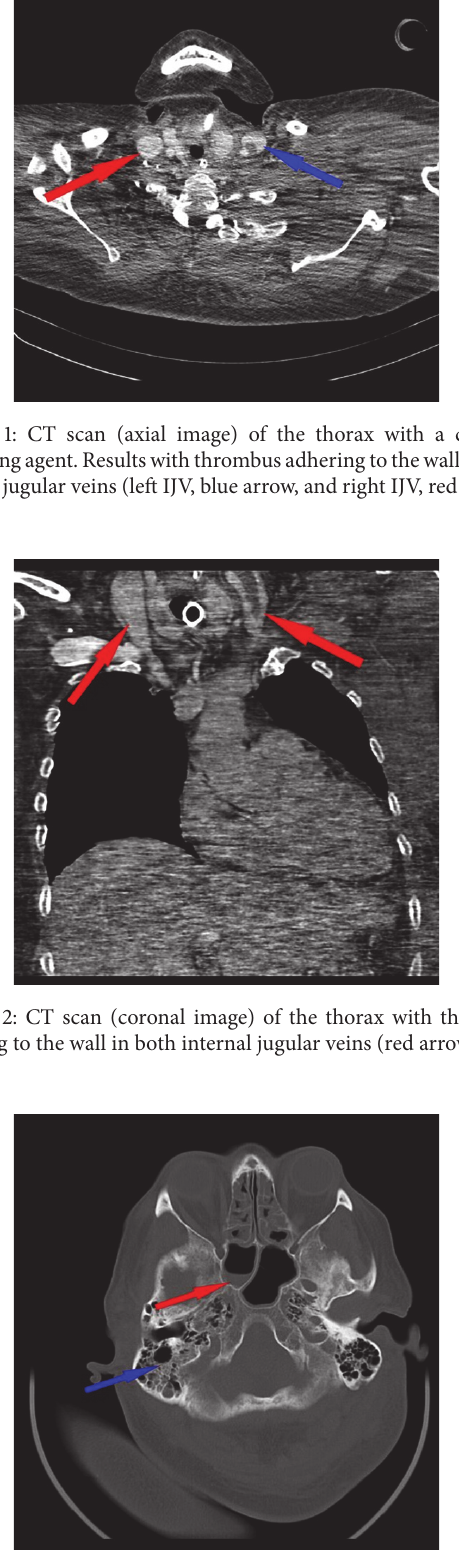
Figure 3: MR imaging of the cranium with bilateral mastoiditis (blue arrow) and sphenoidal sinus with air-fluid level (red arrow). In addition, polypoid swelling of mucous in both ethmoid sinuses.